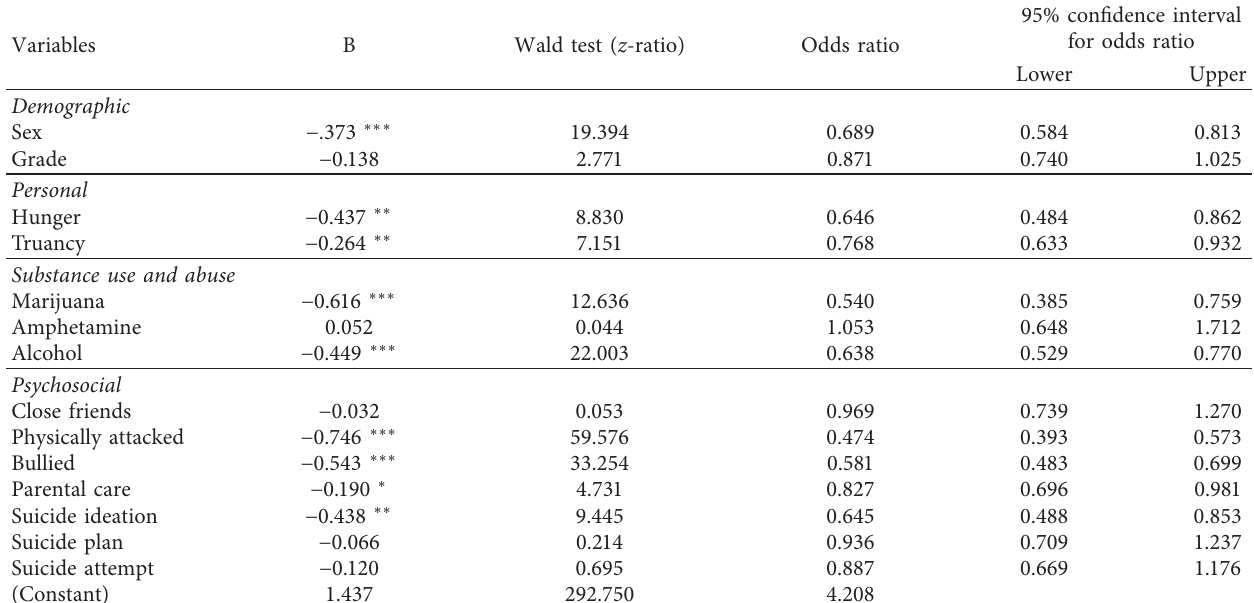
Table 3: Relationship between the significant variables and serious injuries among